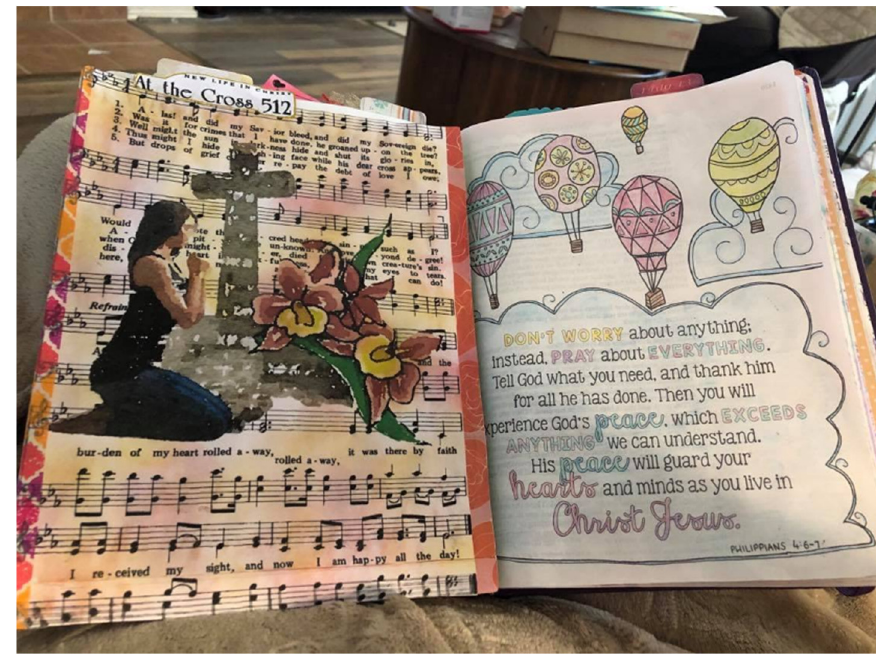
Figure 2. Philippians 4:6–7. With kind permission of the